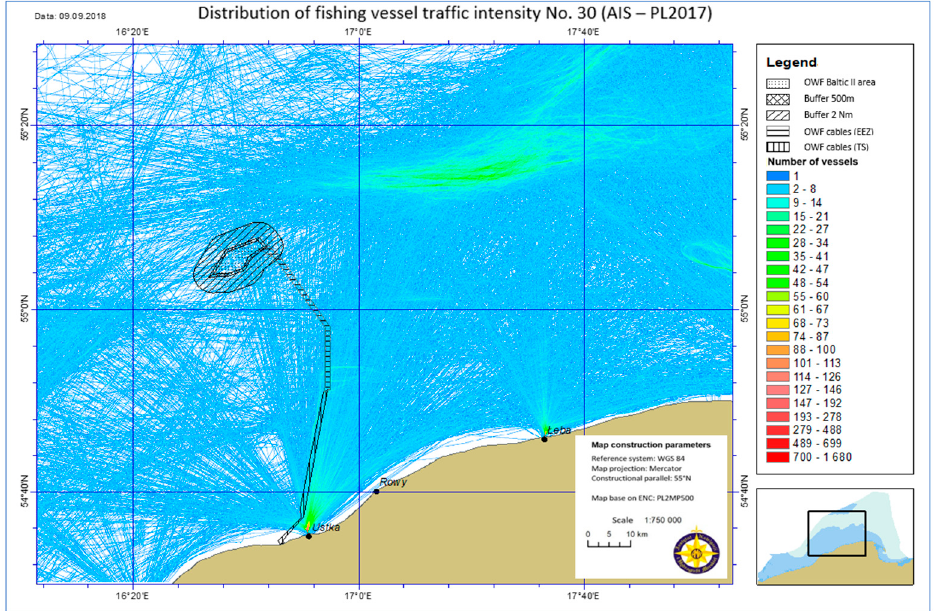
Figure 5. Distribution of the traffic intensity of fishing vessels covering a large sea area around the OWF (vessel type number: 30, AIS-PL 2017).